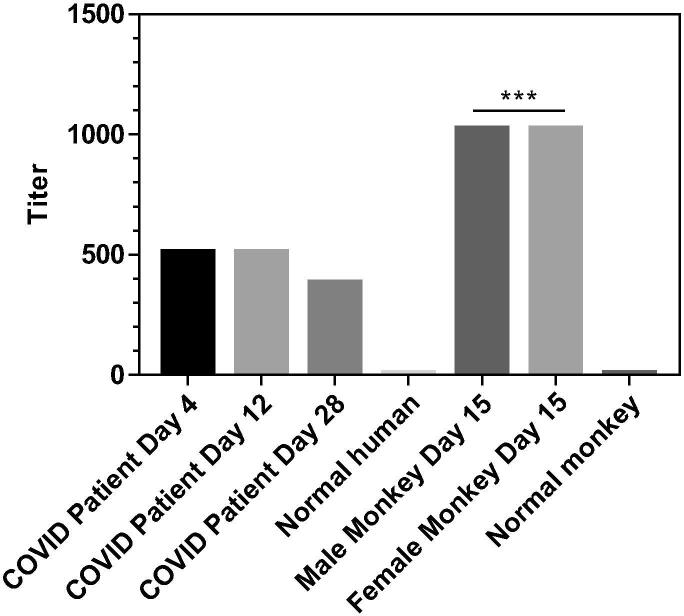
The neutralizing titers of S1-Fc-immunized macaque and COVID-19 Convalescent patient’s sera. The neutralizing titer of macaque and COVID-19 Convalescent patient’s sera was examined using live SARS-CoV-2 (P < 0.001, one-way Anova; n = 4). The vertical coordinate is the neutralizing titer.